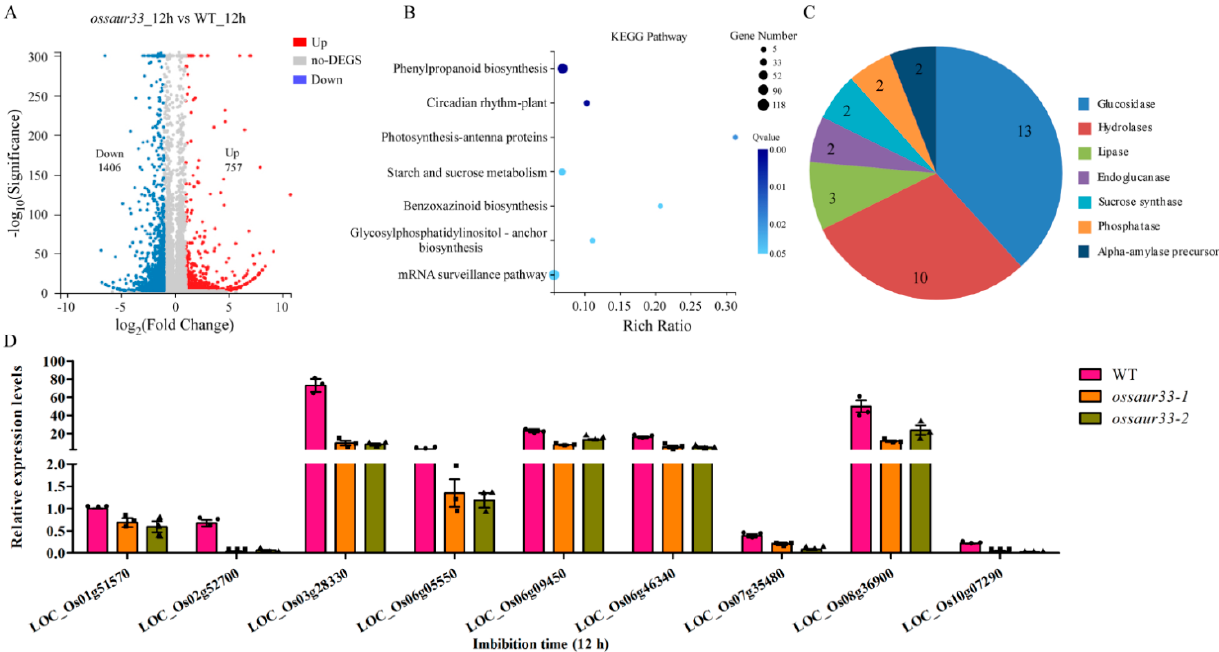
Figure 4. Rice OsSAUR33 alters the mobilization of stored reserves during seed germination. ( A ) The differentially expressed genes (DEGs) with p < 0.001 and fold change ≥ 2 between the WT and the ossaur33-1 mutant in the early (12 h) germinating seeds. Red, up-regulation; Gray, no change; Blue, down-regulation. ( B ) Kyoto Encyclopedia of Genes and Genomes (KEGG) analysis of the DEGs. ( C ) DEGs involved in starch and sucrose metabolism. ( D ) The expression confirmation of starch and sucrose metabolism-related DEGs in the early (12 h) germinating seeds using qRT-PCR. The expression of genes was normalized to that of OsActin . Each column represents the mean ± standard deviation, black small symbol means the value of each replication, n = 3.